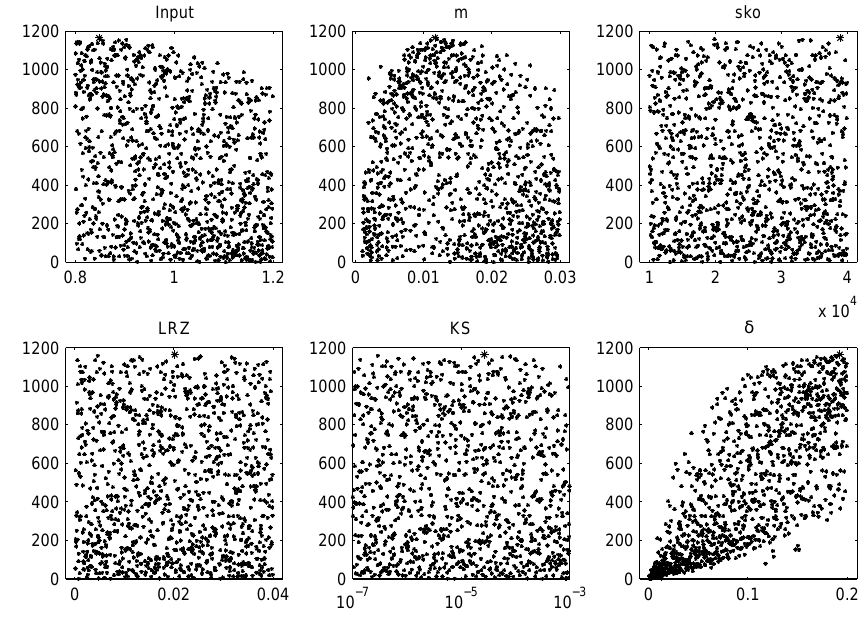
Fig. 6. Scatter plots of the sample of likelihood weights versus uncertain input factors.